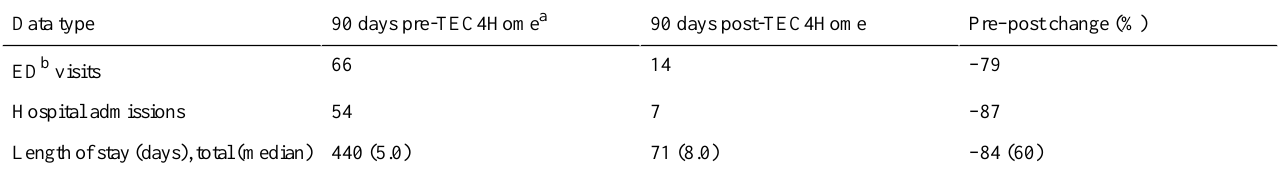
Table 1. Administrative data of change in ED visits, hospital admissions, and length of stay (n=36).